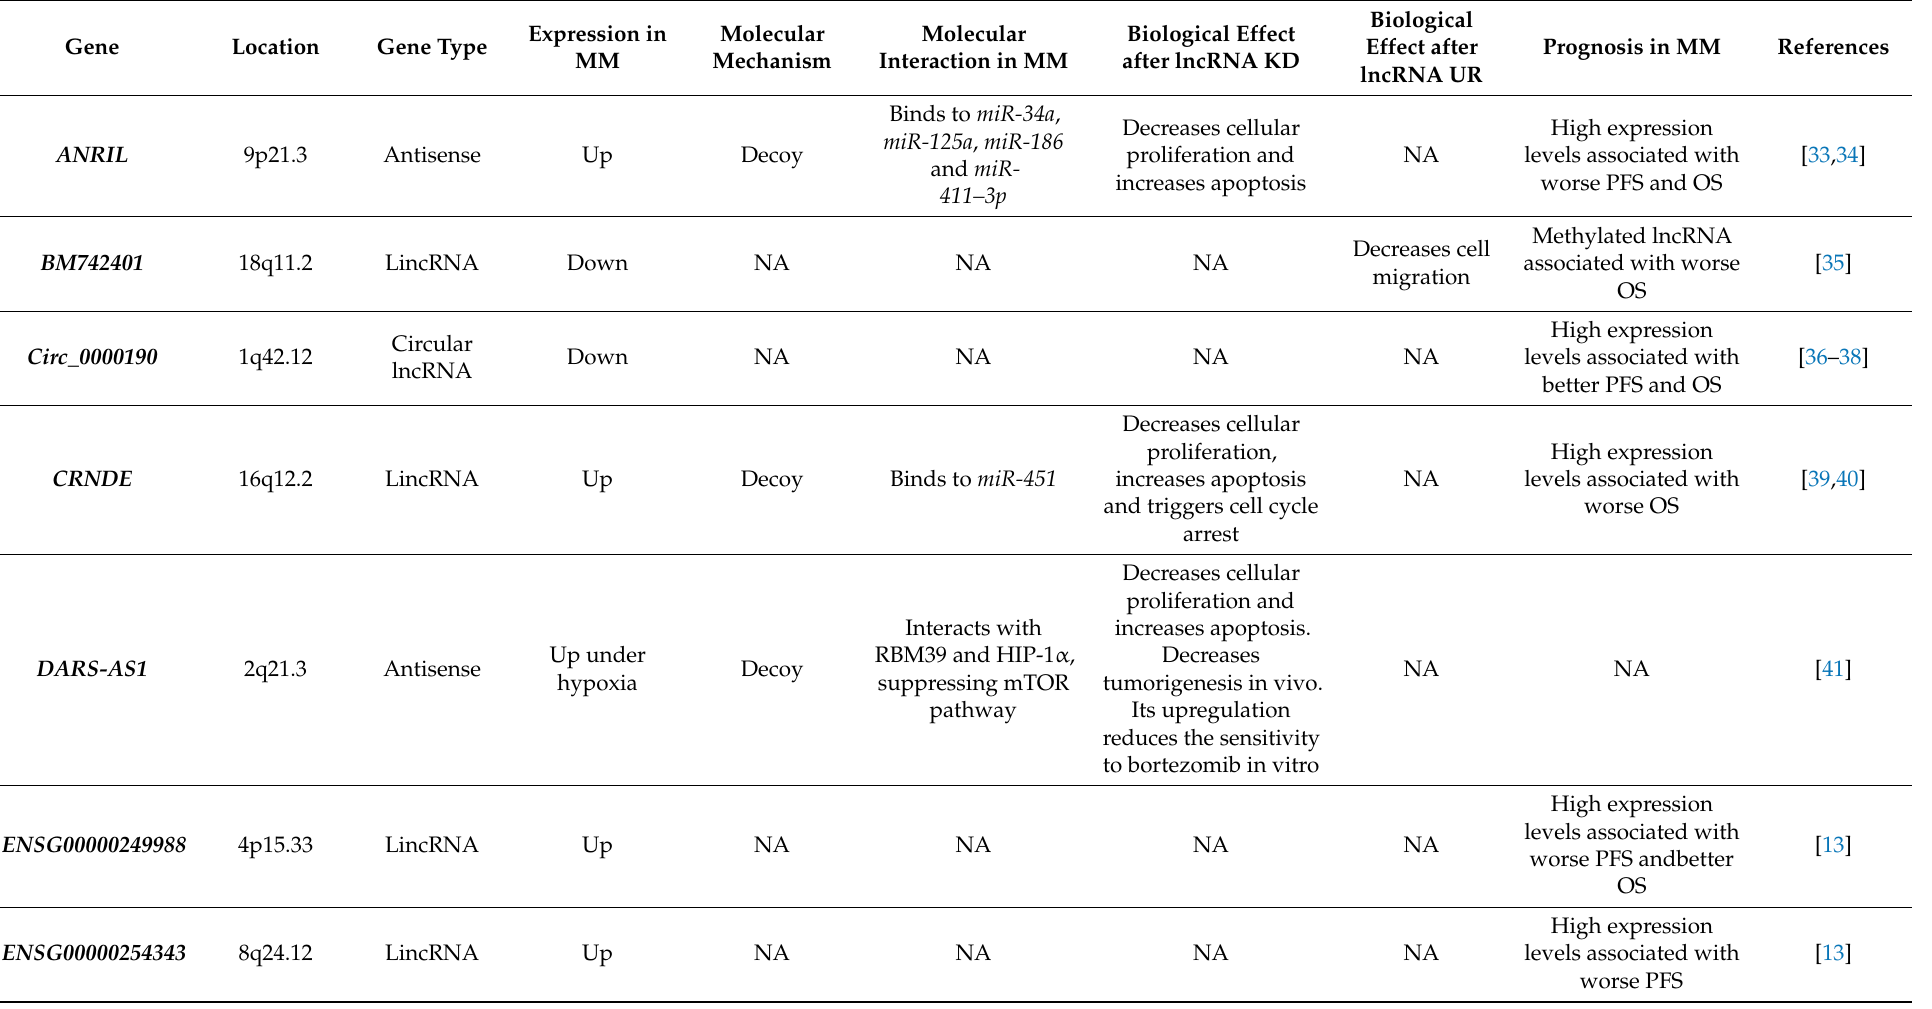
Table 1. Summary of deregulated lncRNAs in MM. MM = multiple myeloma; KD = knockdown; UR = upregulation; up = upregulated; down = downregulated; NA = not available; PFS = progression-free survival; OS = overall